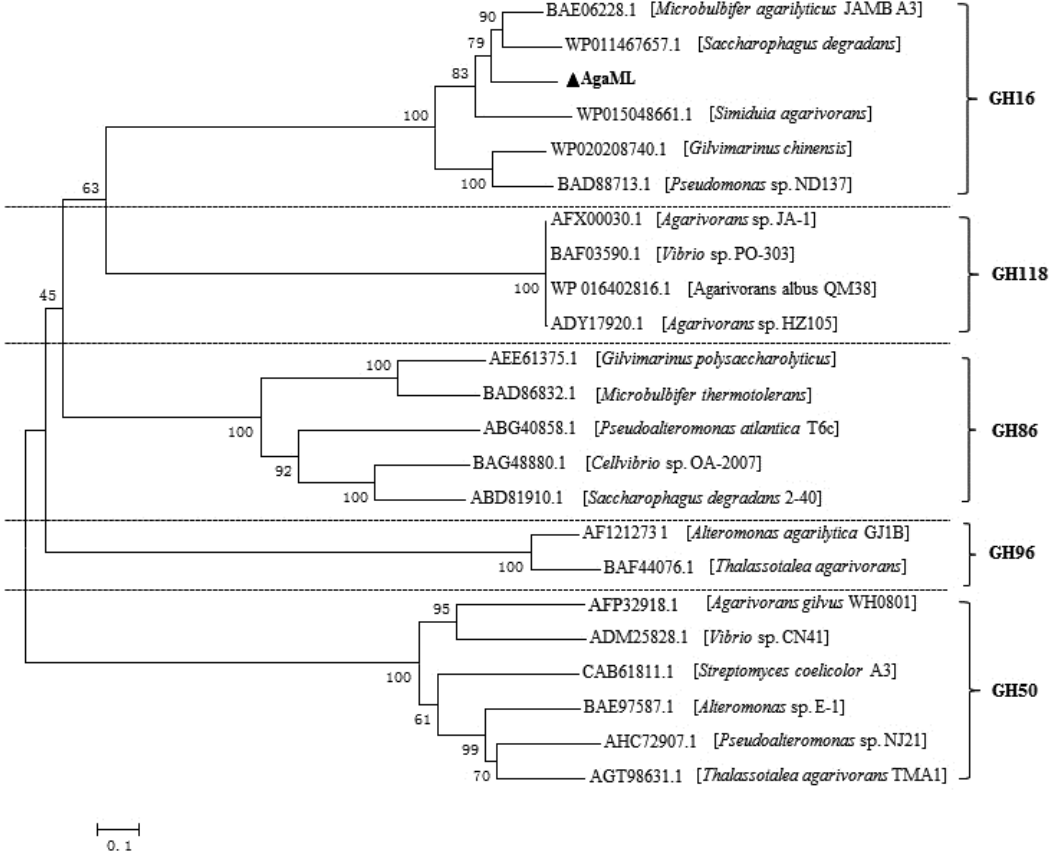
Figure 3. Phylogenetic tree analysis of AgaML with other known agarases based on the amino acid sequences. The AgaML is shown with bold solid triangle. All of the agarase sequences are grouped into five families by the carbohydrate-active enzymes (CAZY) database. Their accession numbers and original genus are indicated on the tree. The phylogenetic tree was constructed using MEGA (Version 5.0) with the neighbor-joining method and 1000 bootstrap replications are indicated at branching points.